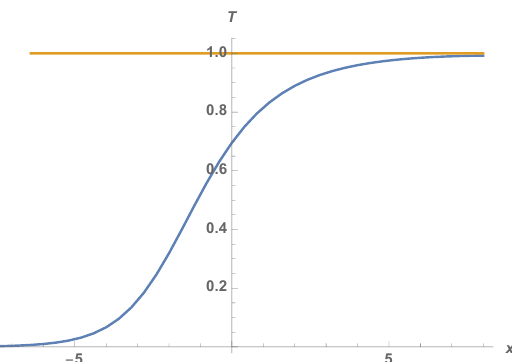
Figure 30 . Evolution of the tachyon for the exponential rolling tachyon deformation, as derived from the shifted 3-point function at the critical parameter p = 1 = 2. In this case the sum over exponential harmonics has (cid:12)nite radius of convergence, and the full pro(cid:12)le is obtained after Pad(cid:19)e resummation. Shown here is the Pad(cid:19)e approximant P 64 ( e x 0 ) which reaches the tachyon vacuum in 64 the in(cid:12)nite future within an accuracy of 0 :